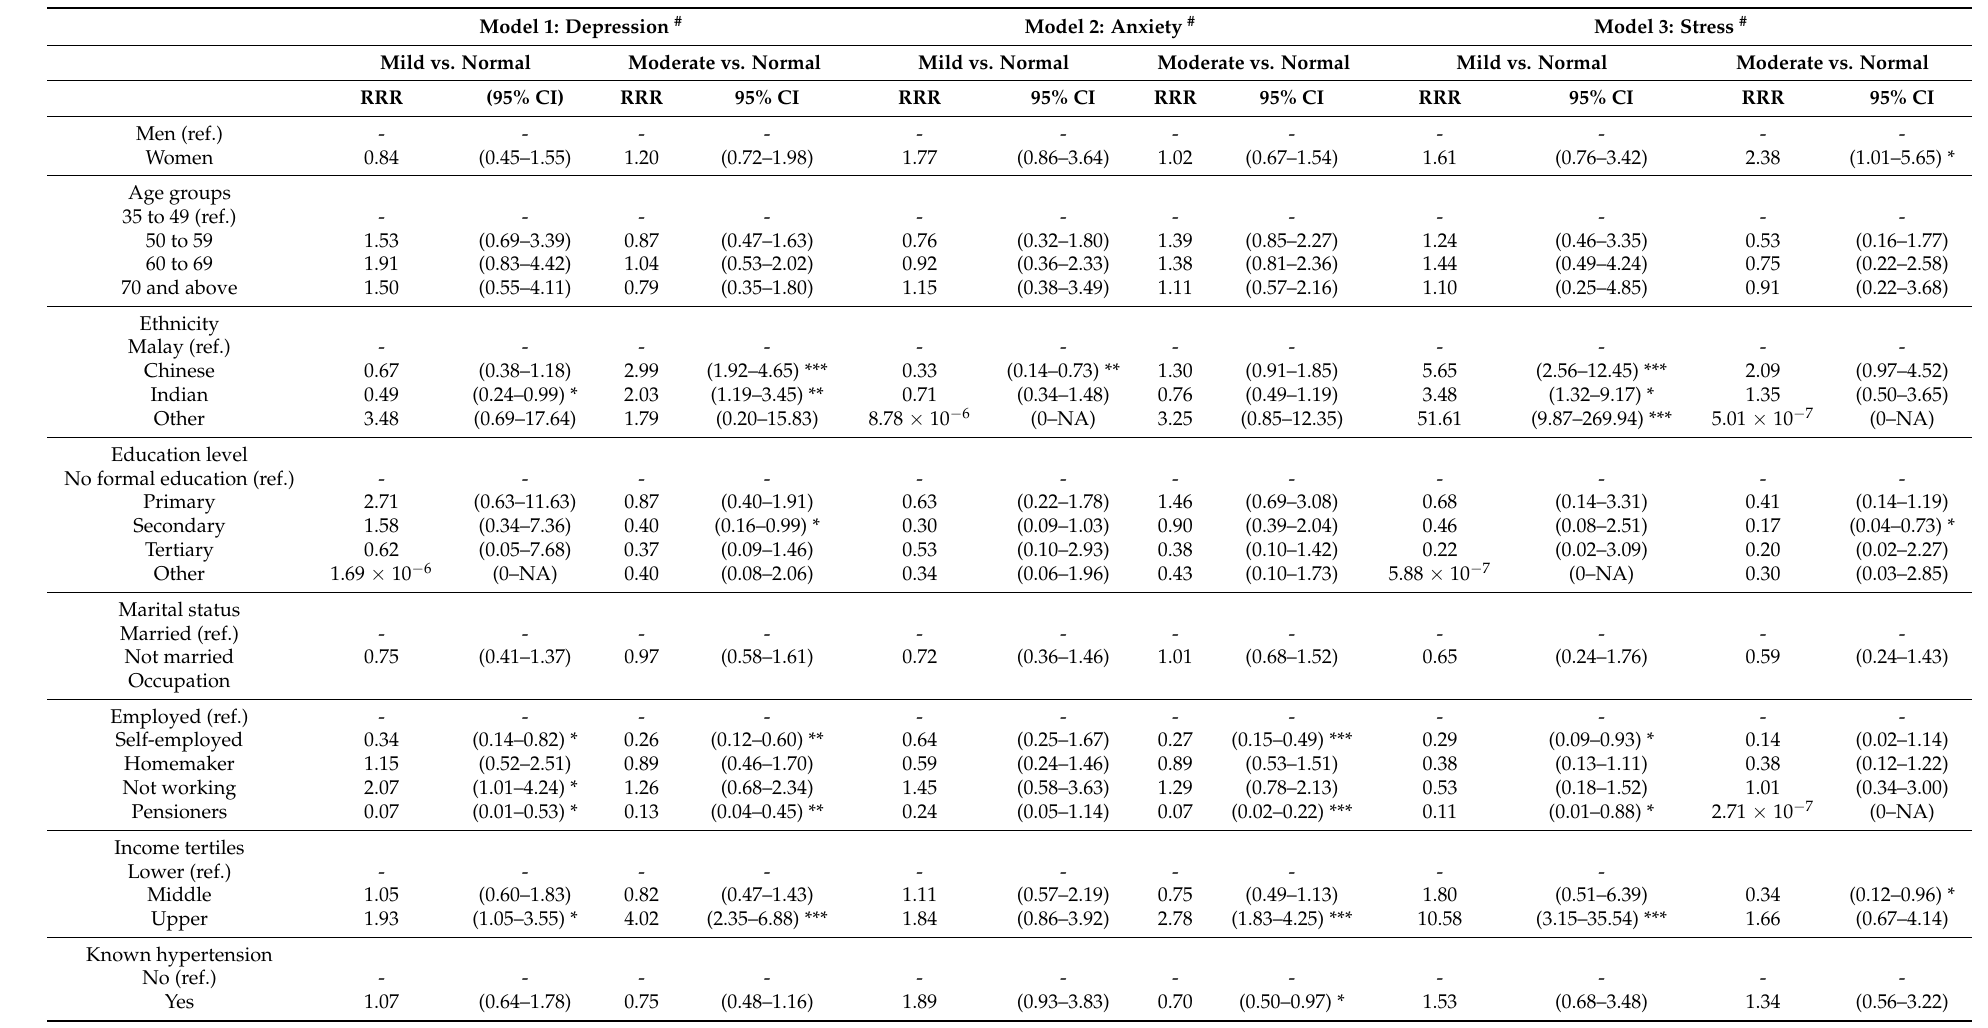
Table 3. Multinomial logistic regression model results for each DASS-21